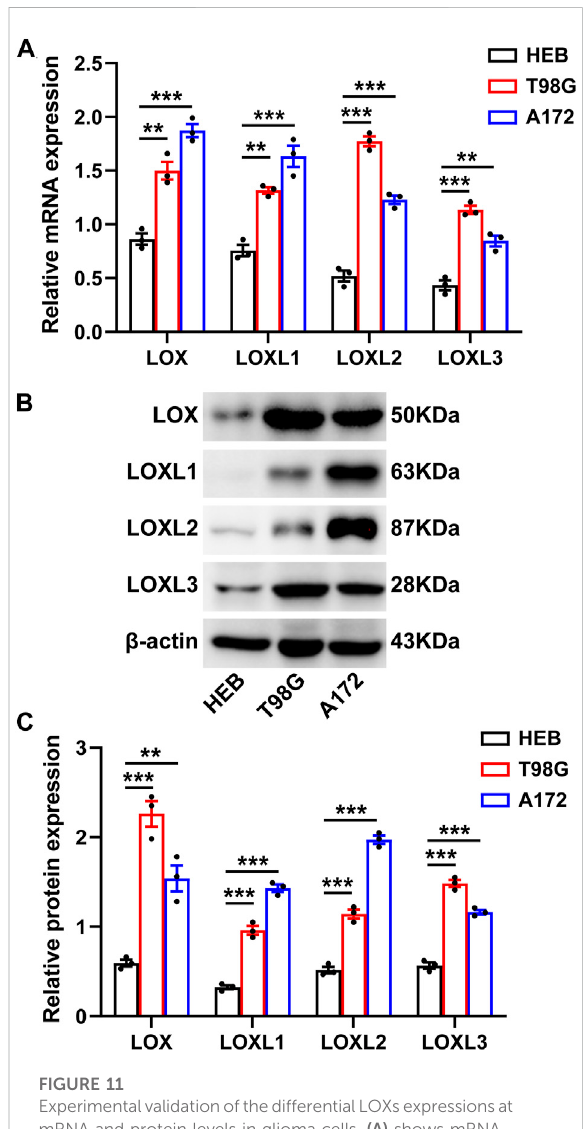
FIGURE 11 ExperimentalvalidationofthedifferentialLOXsexpressionsat mRNA and protein levels in glioma cells. (A) shows mRNA expressions of LOXs including LOX and LOXL1-3 in glioma cells; (B) representative protein bands of LOXs in glioma cells; (C) statistical analysis of protein expressions of LOXs in glioma